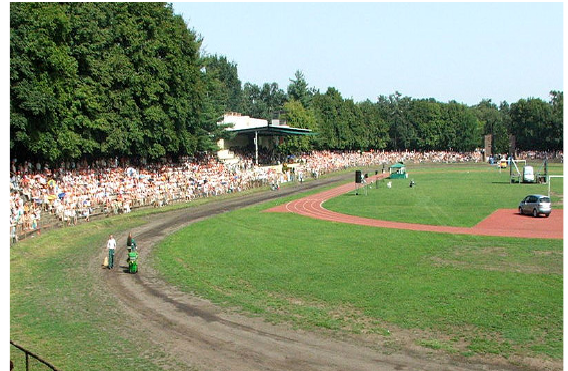
Figure 6. Great Forest Stadium in 2000s. Source: own collection.